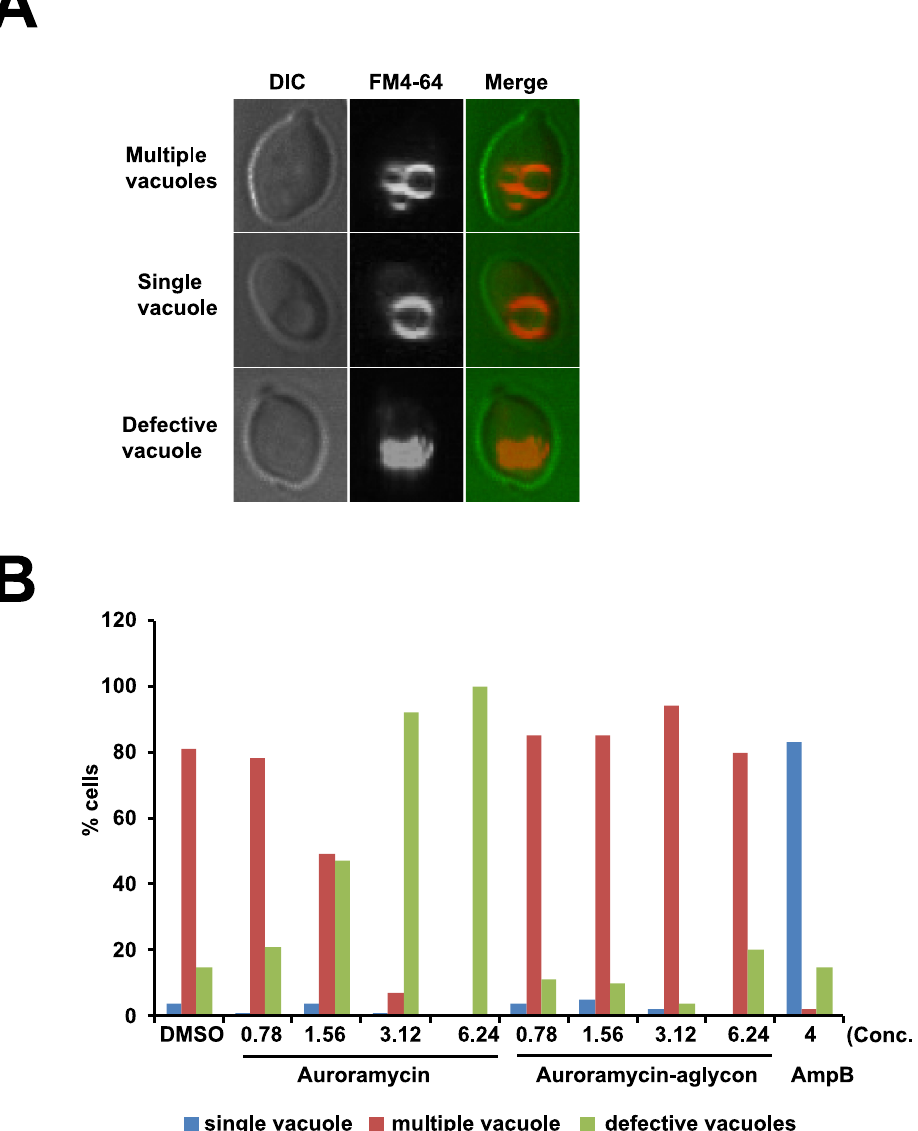
Fig 7. Auroramycin disrupts the vacuolar structure of yeast cells. Wild type yeast cells containing vacuoles pre-labelled with the lipophilic dye FM 4–64 were exposed to DMSO, auroramycin, auroramycin-aglycon or amphotericin B at the indicated concentrations for 1 hour. Vacuolar morphology was analysed by fluorescence microscopy. (A)Based on the FM 4–64 staining patterns, yeast cells were classified into three categories: Single vacuole or multiple vacuoles or defective vacuoles. Representative images for each category are depicted. (B)Quantification of the various categories for cells treated with auroramycin, auroramycin-aglycon or amphotericin B (n = 100 cells).